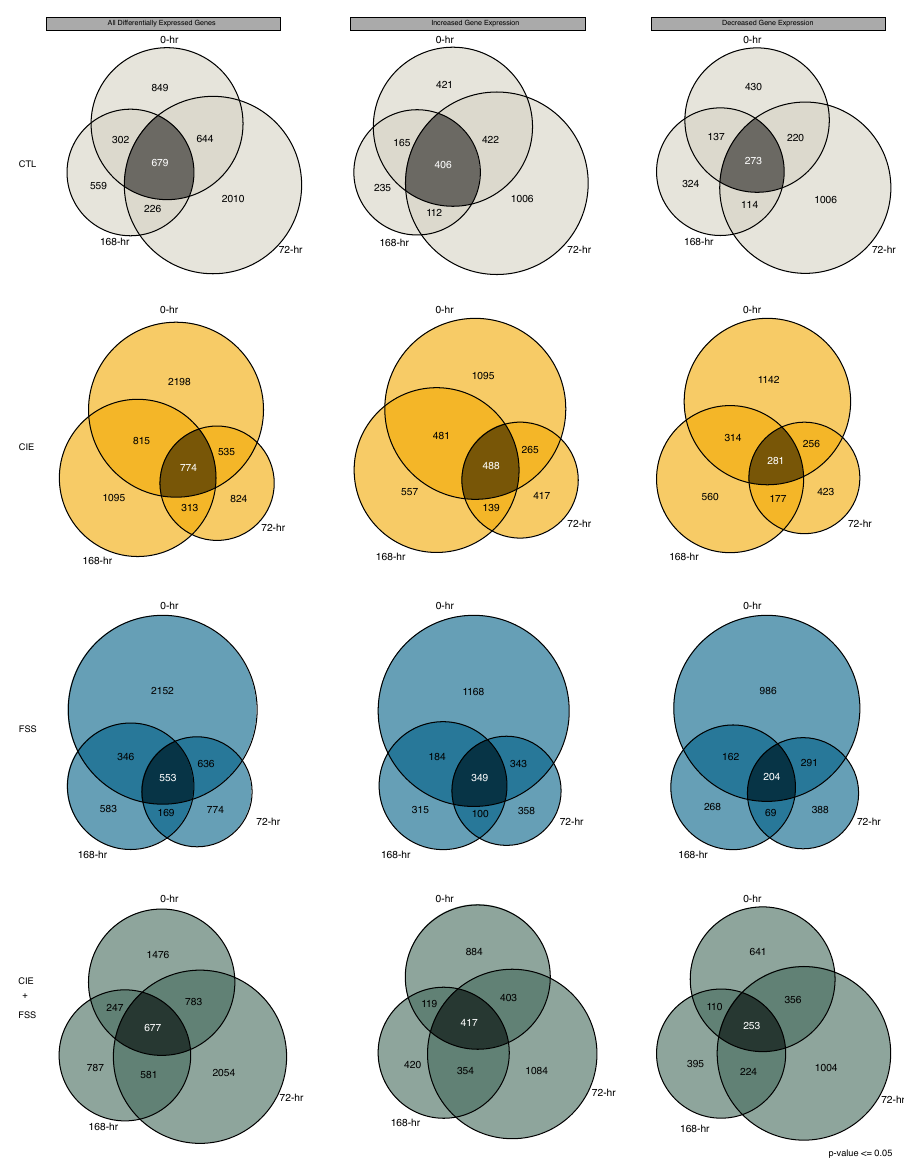
Figure 5. Venn-diagrams within each behavioral group across the examined time-course. Shown are the results for all di ff erentially expressed genes (left), increased gene expression (middle), and decreased gene expression (right) for each of the respective behavioral groups. CTL = light grey, CIE = yellow, FSS = blue, ands CIE + FSS =